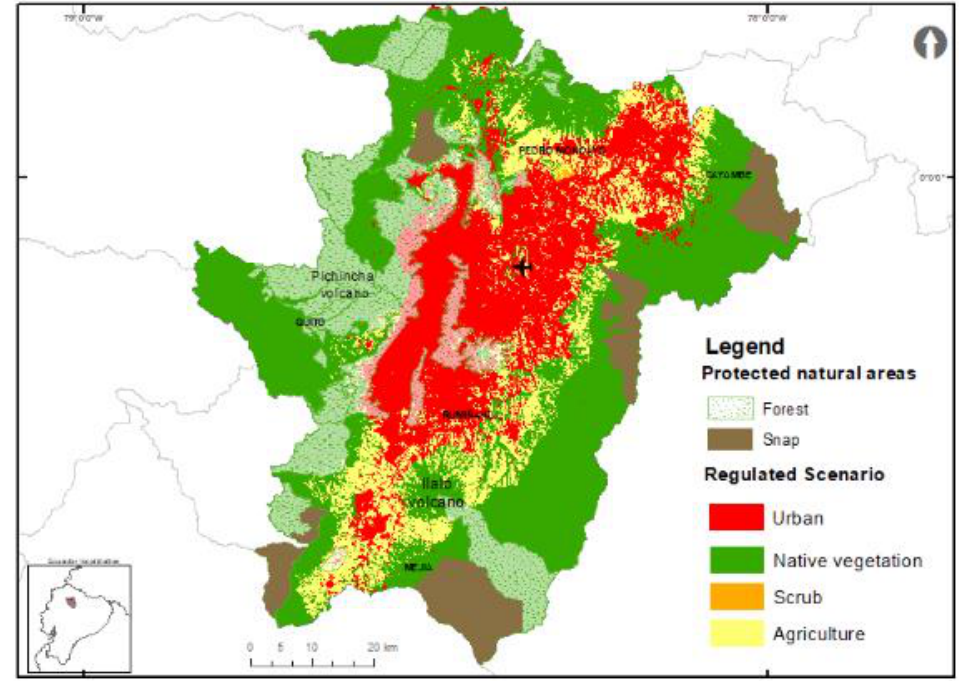
Figure 10. Regulated scenario and natural protected areas, 2050. Source: Ministry of Enviroment, 2017.